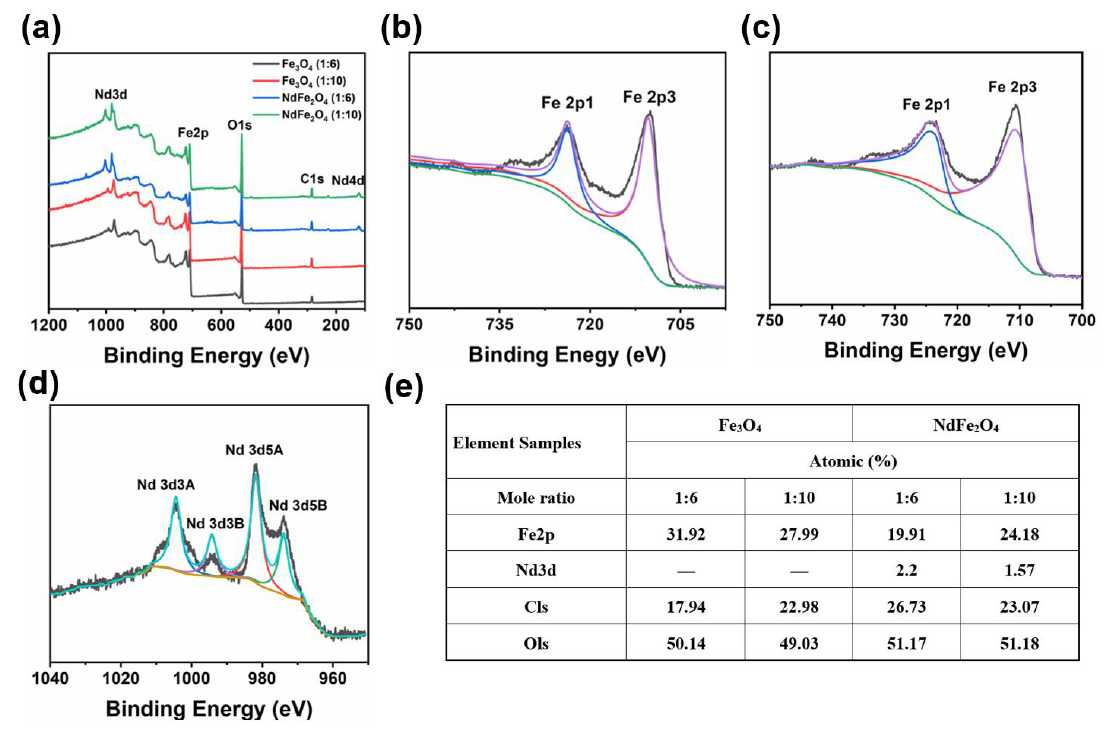
Figure 3. XPS survey spectra and high-resolution spectra of Fe 3 O 4 and NdFe 2 O 4 NPs. ( a ) XPS full spectrum; ( b ) Fe spectrum of Fe 3 O 4 NPs; ( c ) Fe spectrum of NdFe 2 O 4 NPs; ( d ) Nd spectrum of NdFe 2 O 4 NPs; ( e ) Atomic percent of the as-prepared NPs.